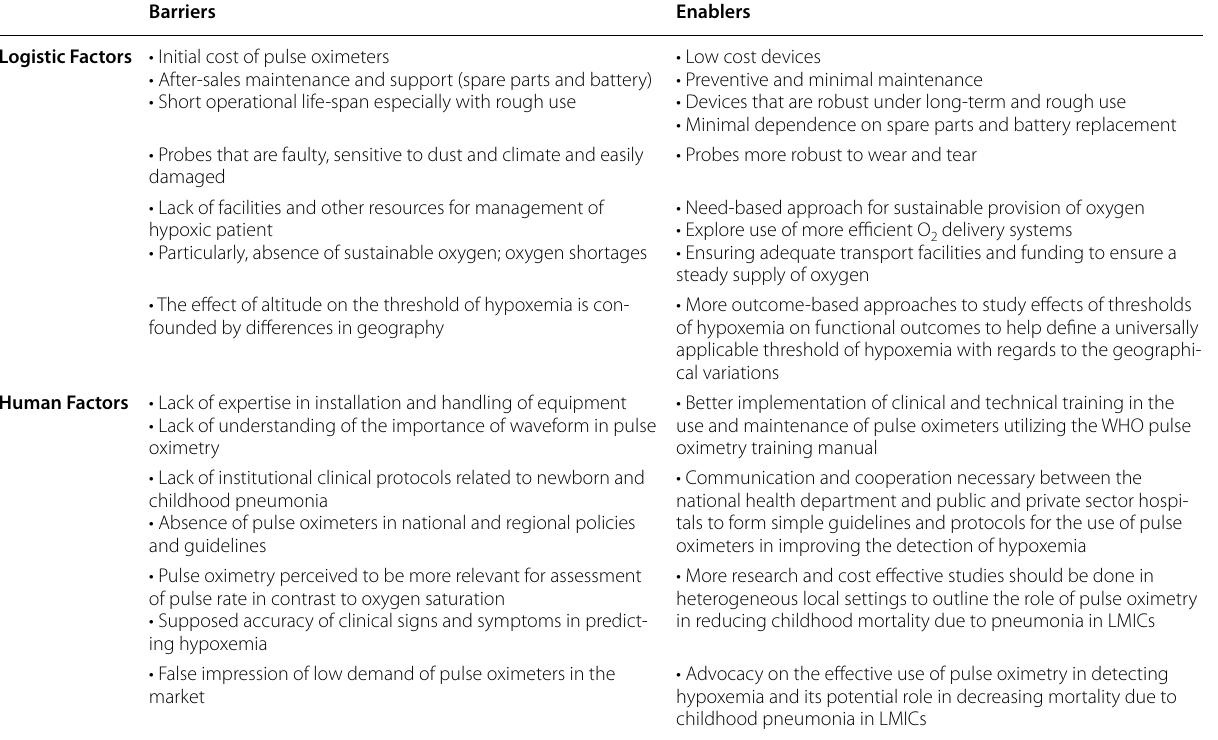
Table 1 Barriers and Enablers for Broad Scale Pulse Oximetry Implementation in LMICs